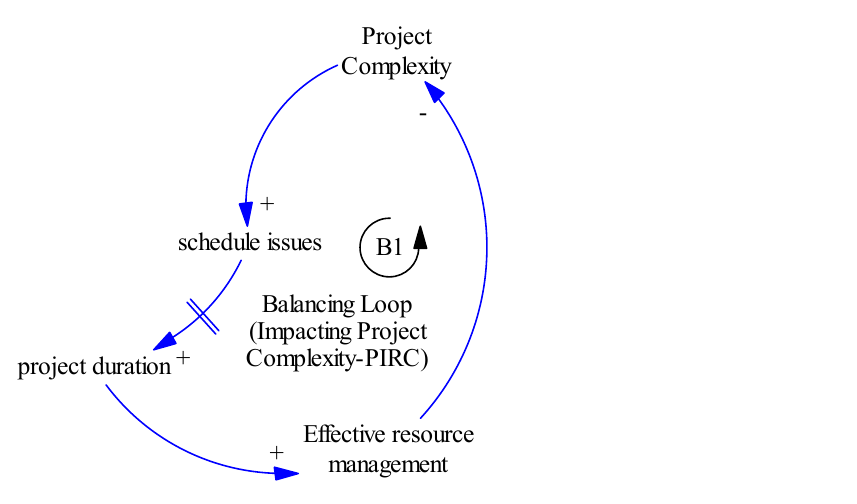
Figure 7. Impact on profitability risk category–complexity (balancing loop-B1).